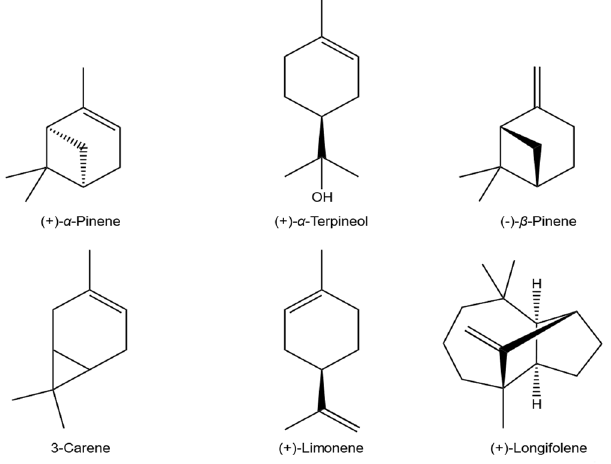
Figure 1. Chemical structures of the main components in the six oil fractions.